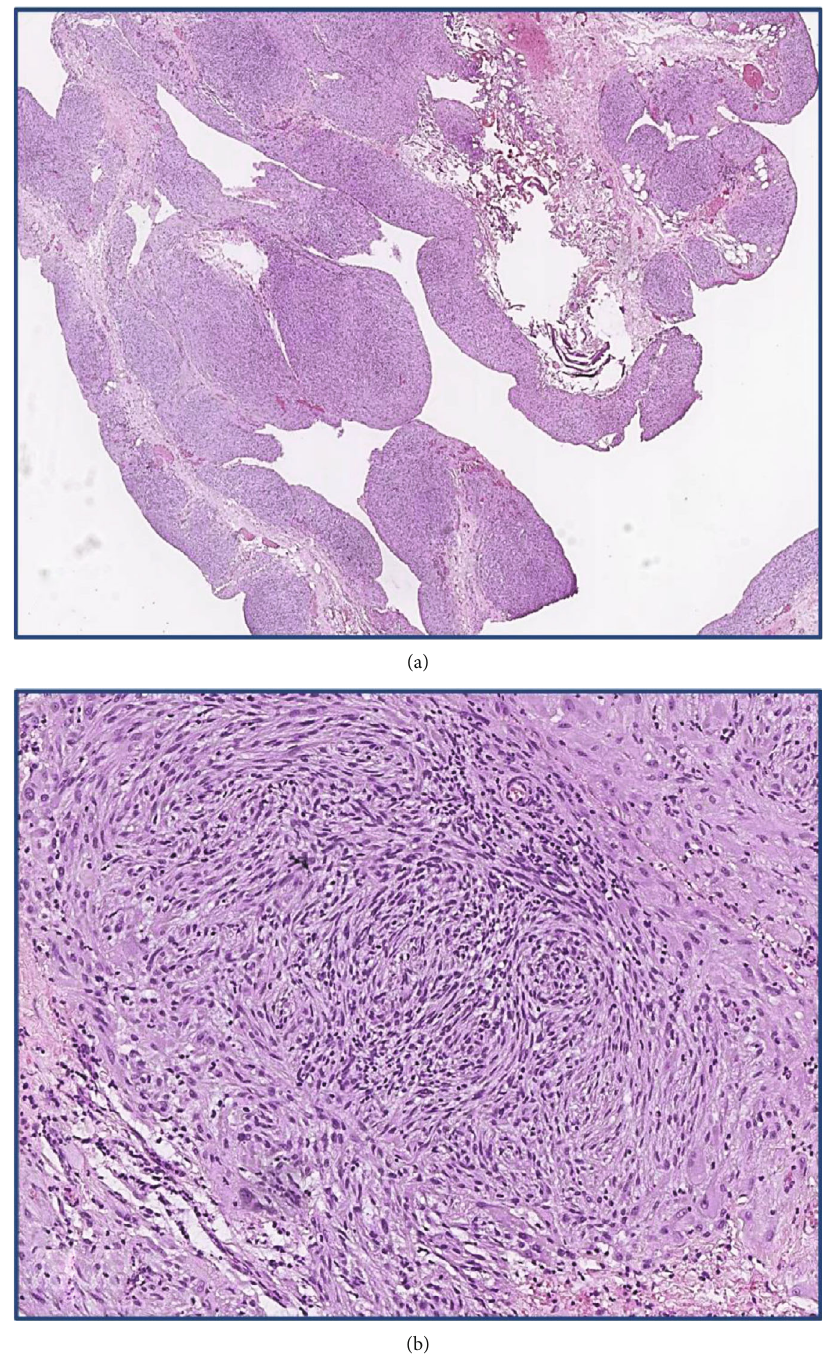
Figure 2: (a) Microscopic examination of the peritoneum sample shows several foci of atypical tissue growth (H&E, magni fi cation × 50). (b) Microscopic examination of the peritoneal lesion demonstrates nodes and fi elds of large spindle and oval cells with uniform nuclei and a moderately developed cytoplasm, forming bundles and swirls (H&E, magni fi cation × 400). H&E: hematoxylin and